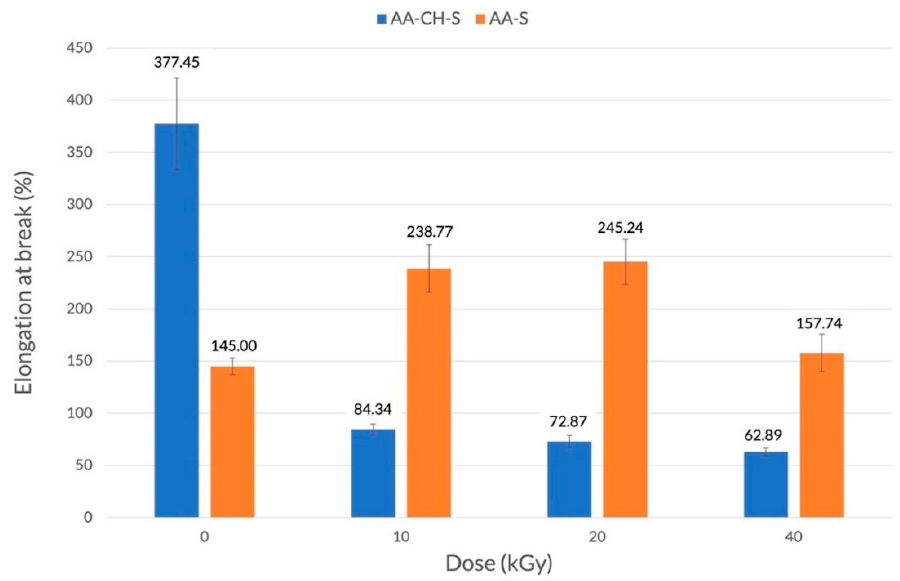
Figure 2. Elongation at break for AA-CH-S (blue) and AA-S (orange) films irradiated with doses of 10, 20, and 40 kGy in the machine